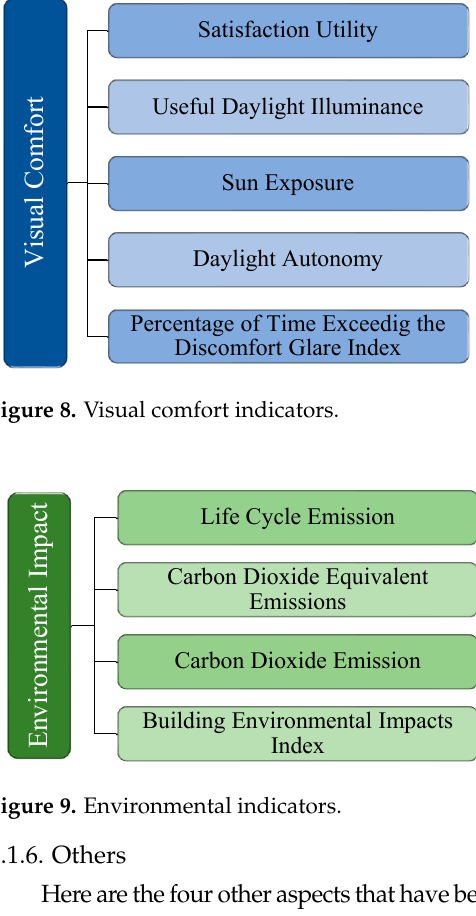
Figure 8. Visual comfort indicators.